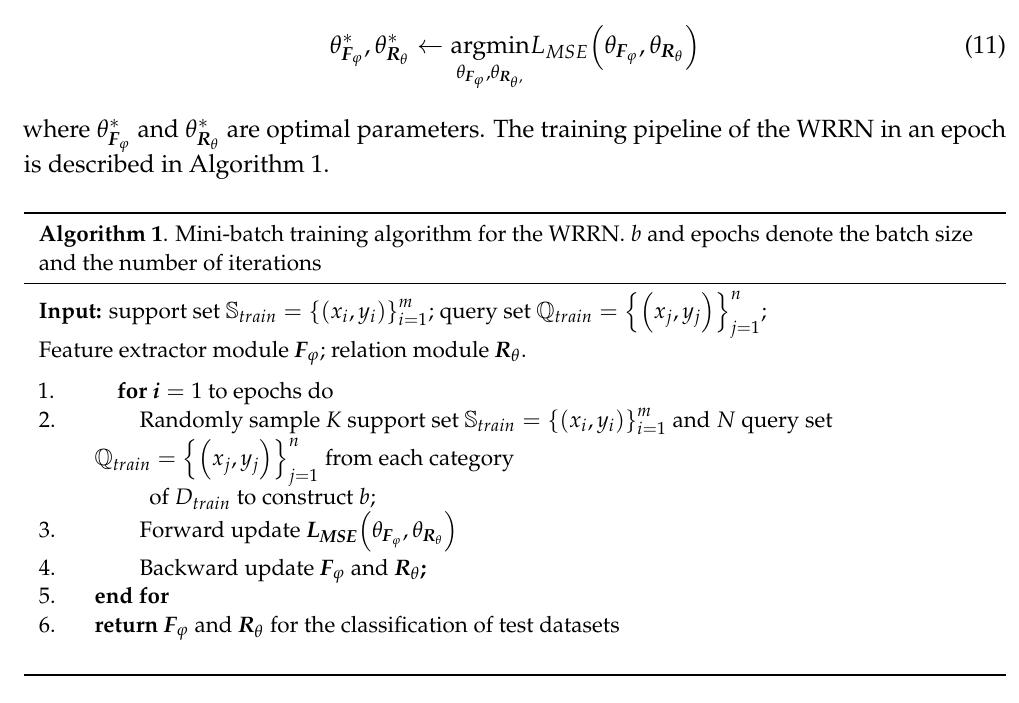
Algorithm 1 . Mini-batch training algorithm for the WRRN. 𝑏 and epochs denote the batch size and the number of iterations